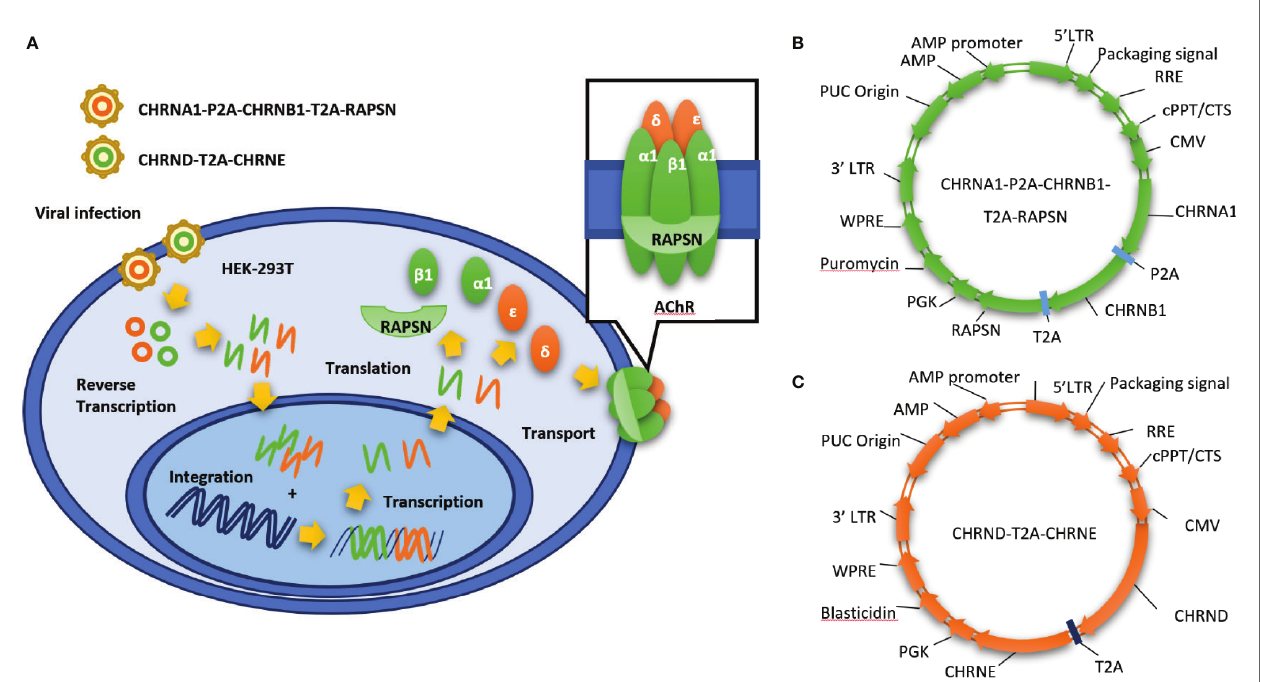
FIGURE 1 | Establishment of stable cell line expressing clustered AChR via a dual lentiviral system. (A) Schematic of our stable cell line expressing clustered AChR (KL525). It is established by infecting HEK 293T cells with dual lentiviral vectors expressing the genes encoding the human AChR a 1, b 1, d , ϵ and the clustering protein rapsyn. (B) CMV-MCS-PGK-Puro lentiviral vectors expressing human rapsyn and the AChR a 1 and b 1 subunits. (C) CMV-MCS-PGK-Blasticidin lentiviral vectors expressing the human AChR d and ϵ subunits. LTR, long terminal repeat; RRE, Rev Response Element; cPPT/CTS, central polypurine tract and the central termination; CMV, Cytomegalovirus; CHRNA1, Cholinergic Receptor Nicotinic Alpha 1 Subunit; CHRNB1, Cholinergic Receptor Nicotinic Beta 1 Subunit; CHRND, Cholinergic Receptor Nicotinic Delta Subunit; CHRNE, Cholinergic Receptor Nicotinic Epsilon Subunit; RAPSN, gene encoding rapsyn; PGK, phosphoglycerate kinase; WPRE, Woodchuck Hepatitis Virus (WHP) Posttranscriptional Regulatory